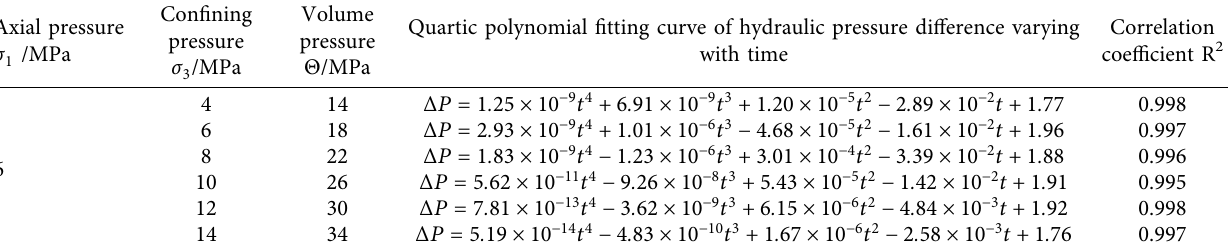
Table 3: The quartic polynomial fitting equations of hydraulic pressure difference varying with time of M07 under different confining